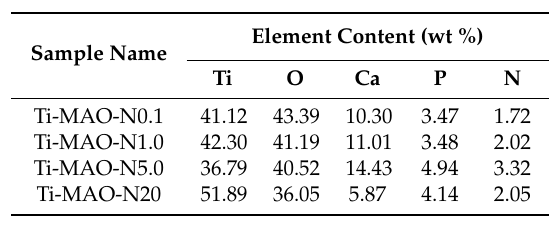
Table 1. Energy dispersive spectrum (EDS) analysis results of samples with different doses of N ion implantation after soaking in biomimetic mineralization solution for 24 days.